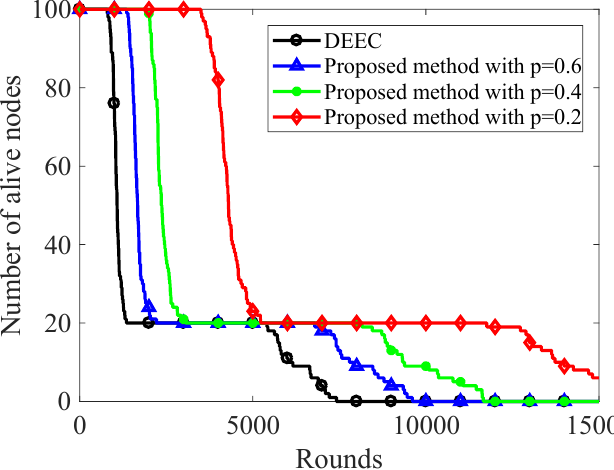
Figure 6. Number of alive nodes over